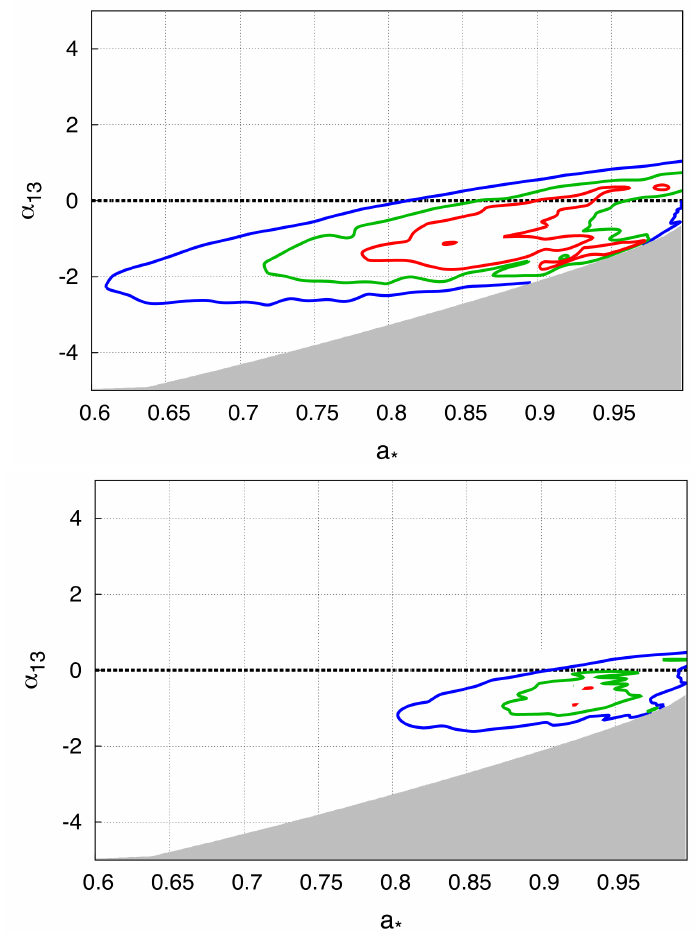
Figure 2. Constraints on the spin parameter a ∗ and the Johannsen parameter α 13 from the study in Ref. [59] of the 2011 XMM-Newton data of 1H0707–495 if we fit the “soft excess” around 1 keV with a thermal model ( top panel) or if we employ a double reflection model ( bottom panel). The red, green, and blue lines indicate, respectively, the 68%, 90%, and 99% confidence level curves for two relevant parameters. The grayed region is ignored because those spacetimes violate the constraint in Equation (6). See the text and Ref. [59] for more details. Note that the constraints reported in Ref. [59] are slightly different because that study used an earlier version of RELXILL _ NK , and therefore the constraints reported here should be more